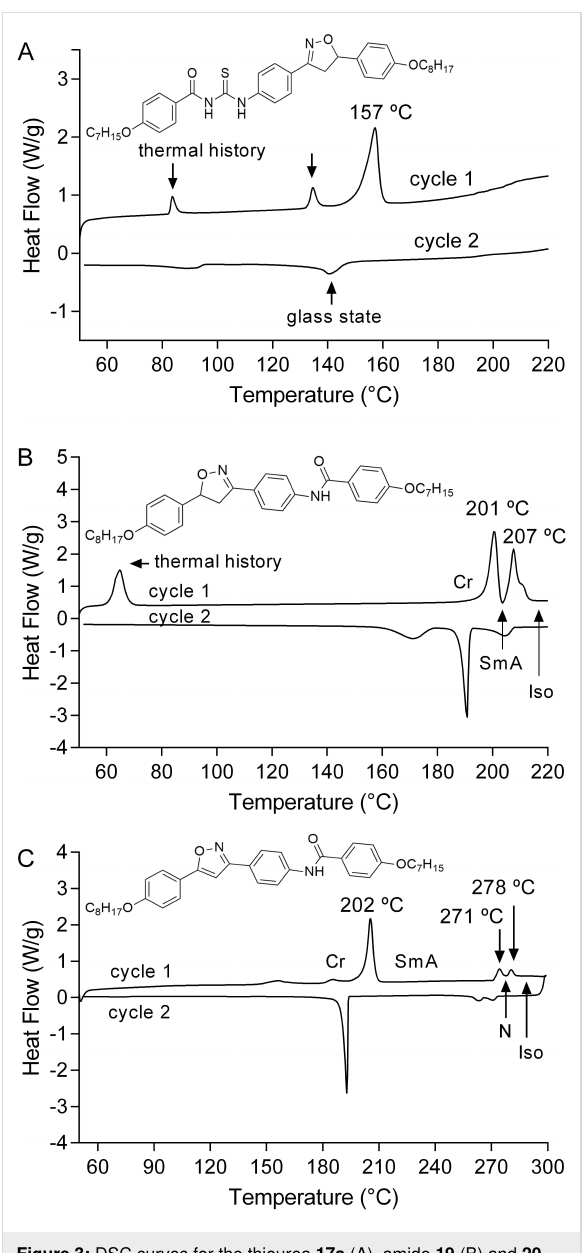
in 19 can resonate to the nitrogen atom in the isoxazoline ring, 21 does not. All analogous compounds such as thiourea 18a , b , containing an isoxazole ring, displayed enantiotropic SmA and N mesophases, confirming that the isoxazole ring favors the formation of a stable mesophase. It is interesting to notice that the nematic mesophase appeared only in compounds with the isoxazole ring ( 18a , 18c and 20 ), confirming that a longitudinal diffusion is favored for this type of LC compounds